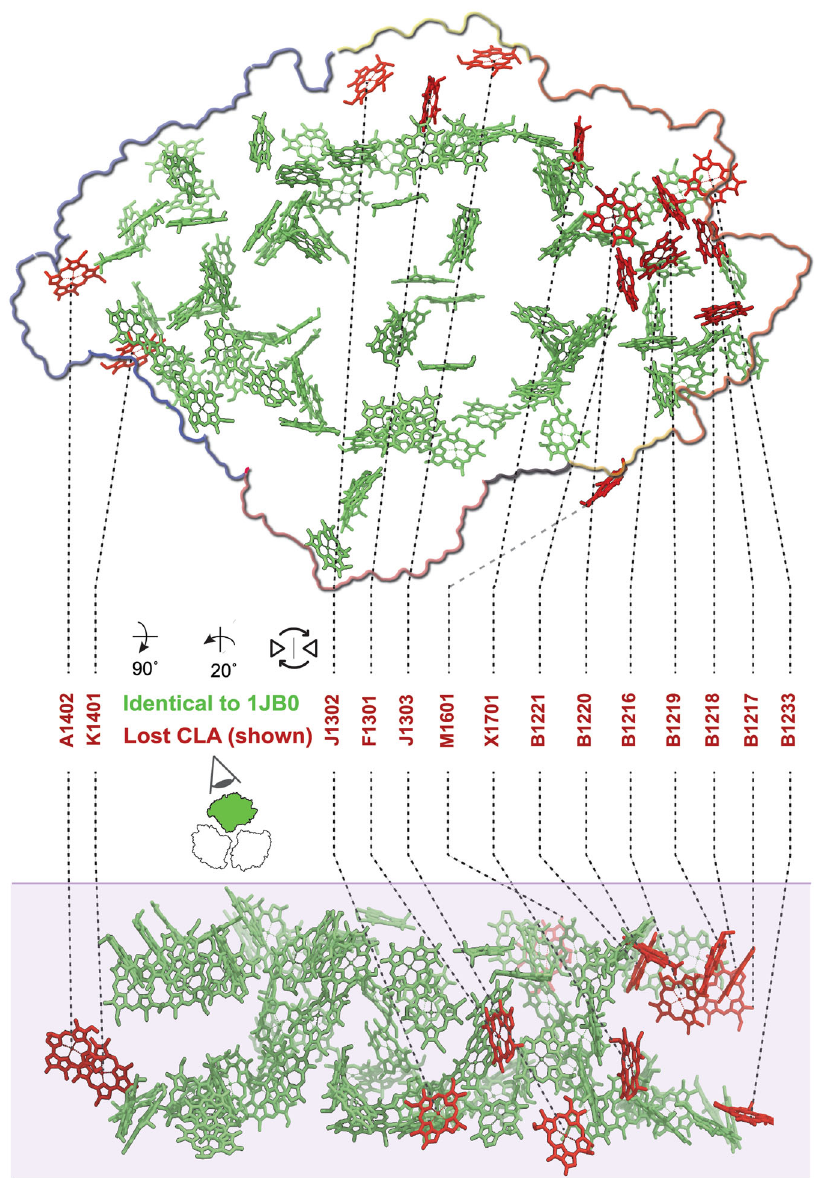
Fig. 7 Chlorophyll network. View on the membrane normal from the stromal side (upper panel) with monomer outlined according to subunit color. Lower panel: side-view along the membrane plane with the membrane indicated in shade. Chlorophylls found in both monomer and trimer structures are colored in green, chlorophylls not found in the monomer structure are colored in